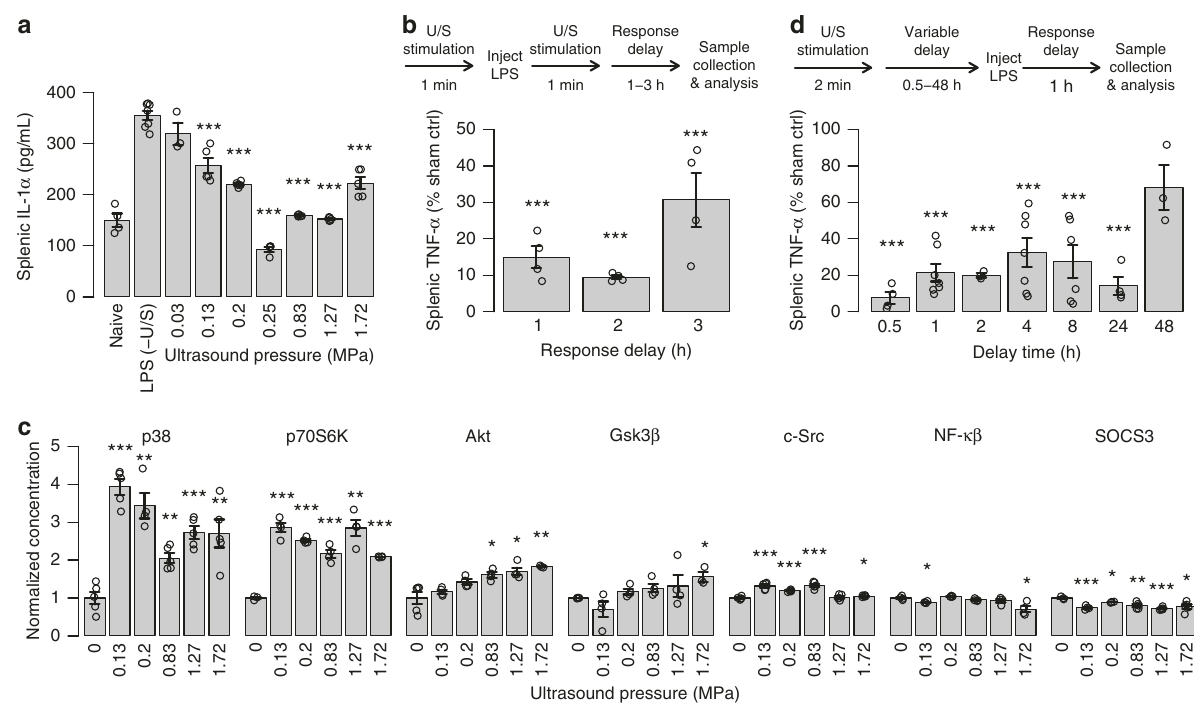
Fig. 3 Lasting effect of splenic U/S neuromodulation. a Splenic IL-1 α concentrations measured from the same samples as Fig. 2c – e. n = 5 for all experimental conditions, except LPS – (U/S) controls which were n = 7. b Study timeline and data designed to measure the concentrations of splenic TNF after response times of 1 – 3 h (i.e., the time the sample was harvested post treatment). n = 4 for each experimental condition. c Normalized concentrations (compared to LPS controls) of activated/phosphorylated kinases with or without U/S stimulus pressures from 0.03 to 1.72MPa. n = 4 for each experimental condition. d Concentration of splenic TNF after protective (pre-LPS) U/S treatments after delay times from 0.5 to 48 h prior to LPS injection. n = 5. The asterisks mark statistical signi fi cance using two-sided t -test versus LPS only controls (with p -value thresholds; * p < 0.05, ** p < 0.01, *** p < 0.001). All experiments in this fi gure were performed using the same US settings as in Fig. 2 (0.83